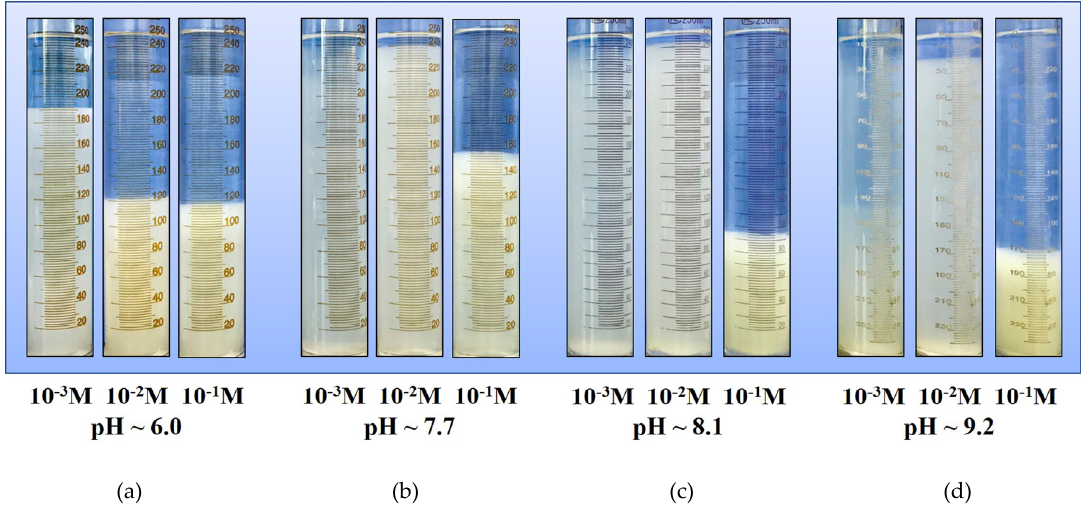
Figure 7. Photos of the Na-Mt suspensions taken after settling for 12 h under different NaCl concentration (10 − 3 , 10 − 2 , 10 − 1 M) and pH: ( a ) pH ~ 6.0; ( b ) pH ~ 7.7; ( c ) pH ~ 8.1; ( d ) pH ~ 9.2.